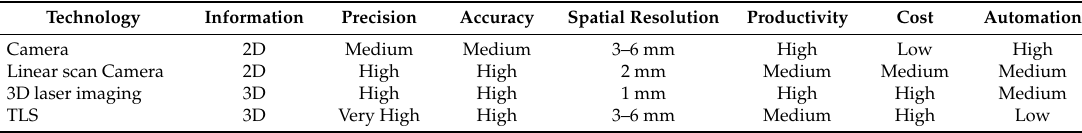
Table 3. Technological solutions